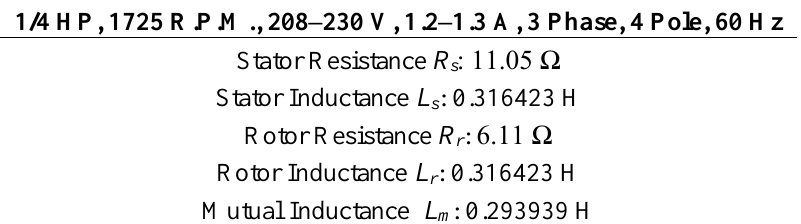
Table 1. Parameters of the induction motor.